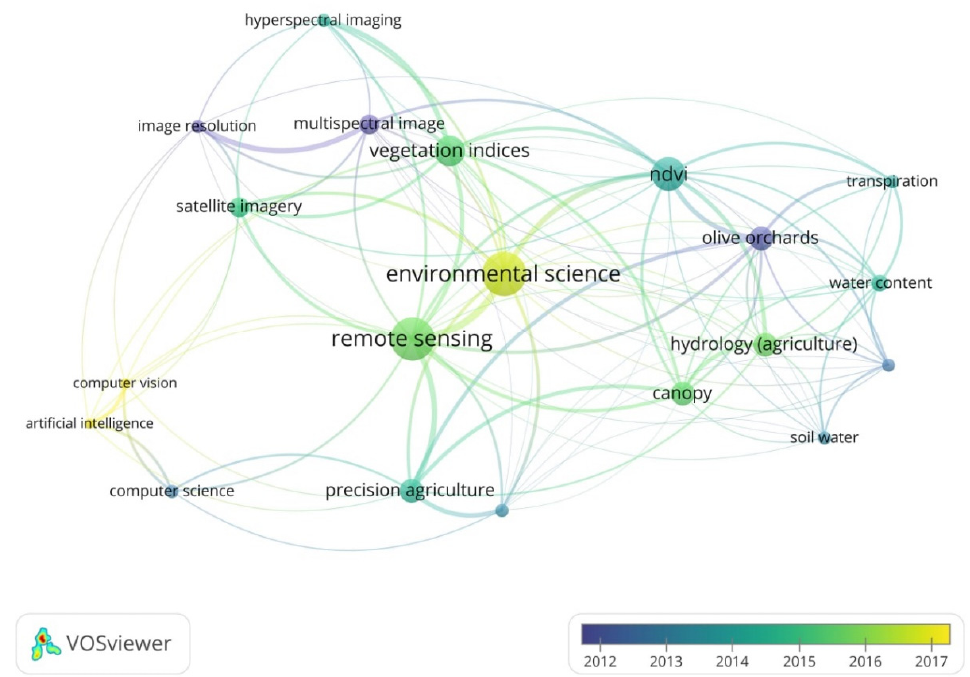
Figure 3. Keywords occurrence and clustering by VOSviewer 1.6.18. Colors indicate the year in which each title and word contained in the abstracts were used more. Lines represent co-occurrence link strength among terms. Table 1. The main vegetation indices (VIs) used in remote sensing research in olive growing.